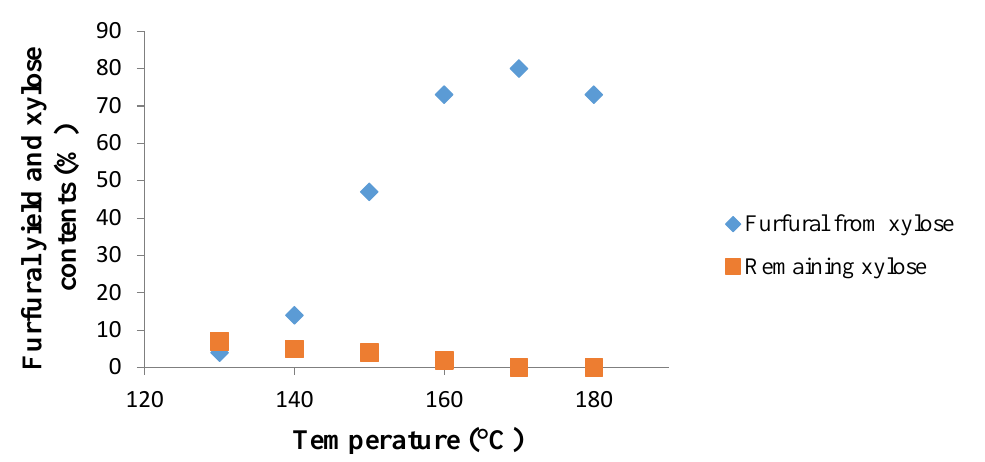
Figure 1. Effect of reaction temperature on furfural yield. Reaction conditions: Nafion NR50 (two pellets), NaCl (95 mg), D -xylose (1.0 mmol), water (1 mL), CPME (3 mL) and MW, 1 h.